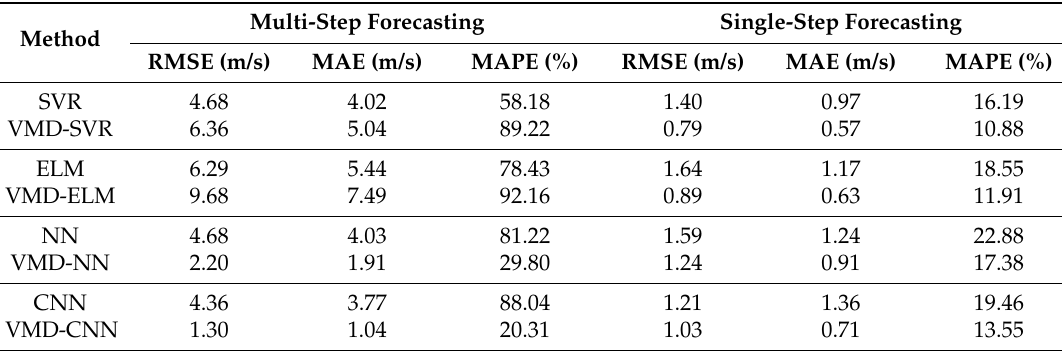
Table 3. Multi-step and single-step forecasting results of different